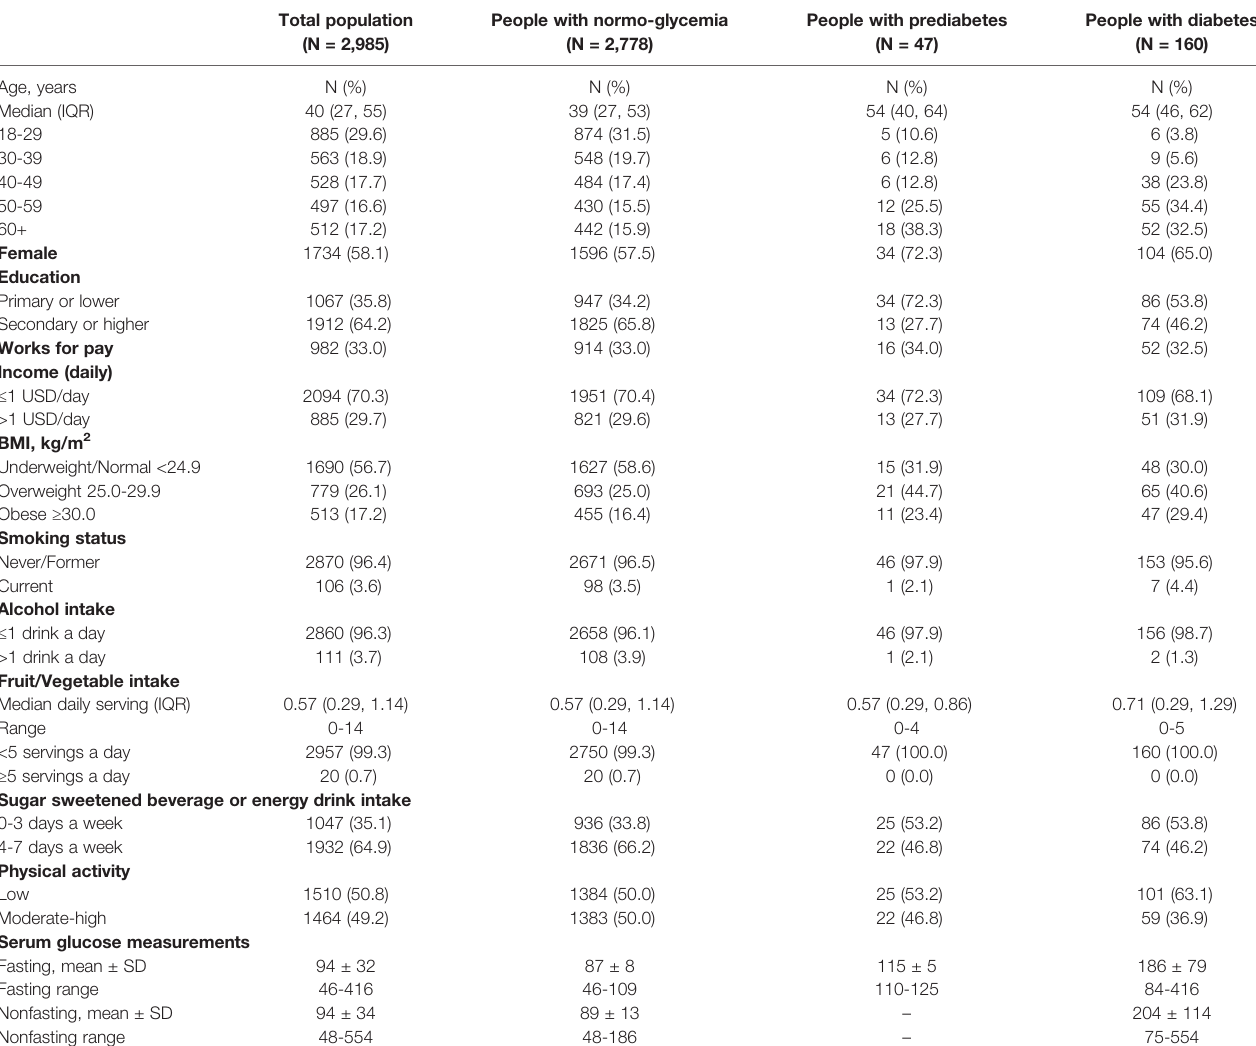
TABLE 1 | Sociodemographic and clinical characteristics for cohort of haitian adults.